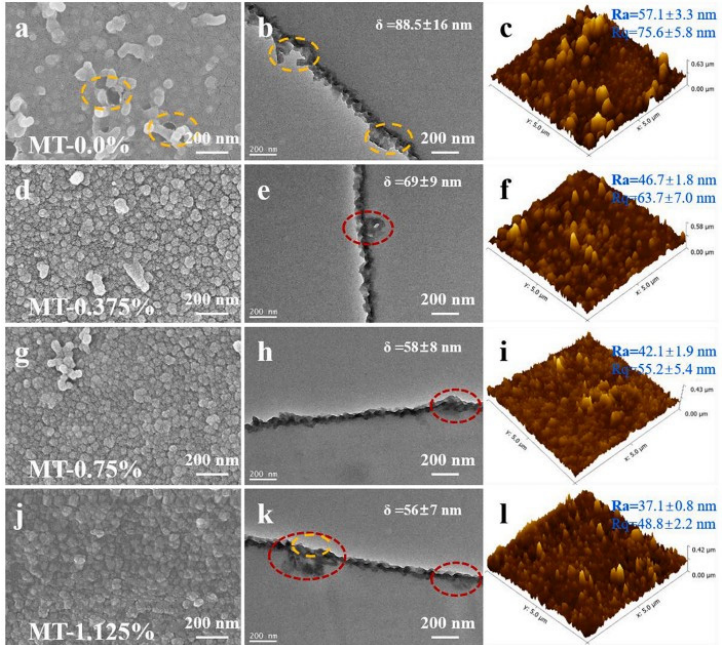
Figure 12. SEM images of the top view of nanofiltration membranes (NFMs) (left), TEM image of cross-sectional views for PA layers (middle) and AFM topographical images of NFMs (right): ( a – c ) MT-0.0%, ( d – f ) MT-0.375%, ( g – i ) MT-0.75%, and ( j – l ) MT-1.125%. Yellow circles indicate defects and red circles represent HF-MoS 2 , diagram taken from [97].